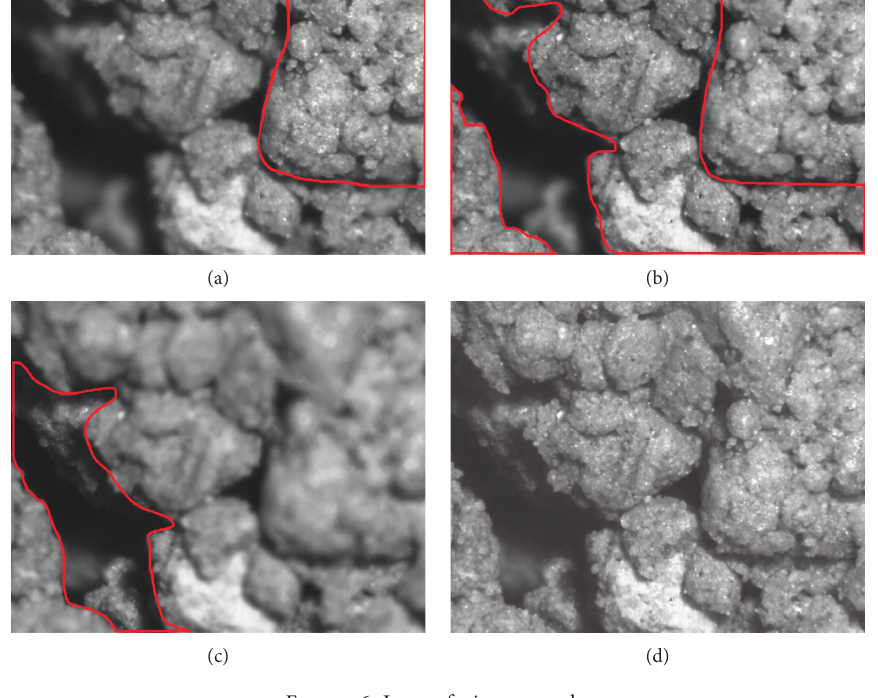
Figure 6: Image fusion example.